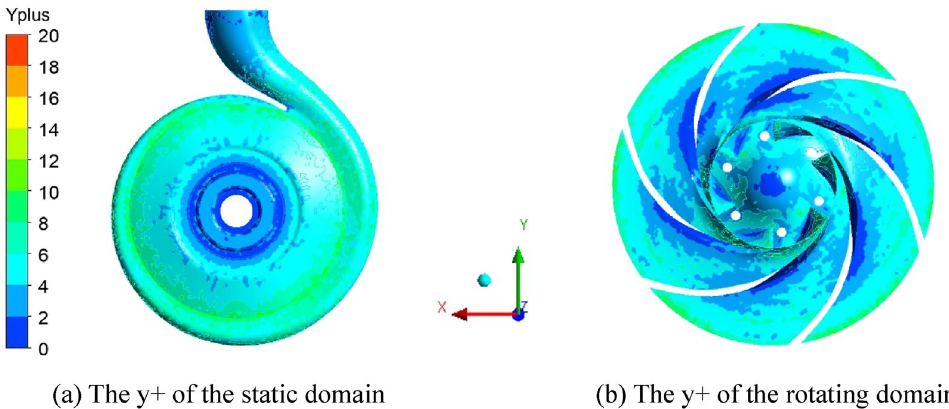
Figure 2. The y + distribution at the volute and the pump chamber and the